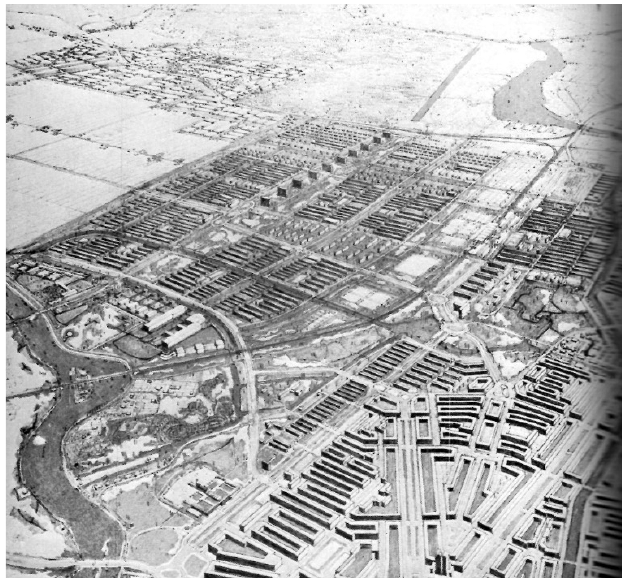
Figure 7. Amsterdam General Extension Plan, 1935, by Cornelis van Eestern and team. H.P. Berlage’s Amsterdam South plan, already built out by 1935, is at the lower right. Source: Giedion (1942, p.